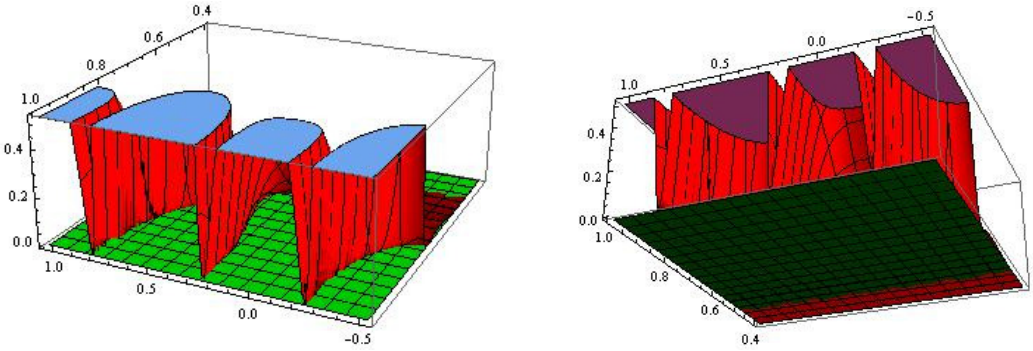
Figure 3. The graph of x 3 = They intersect at a curve which looks like a straight line.